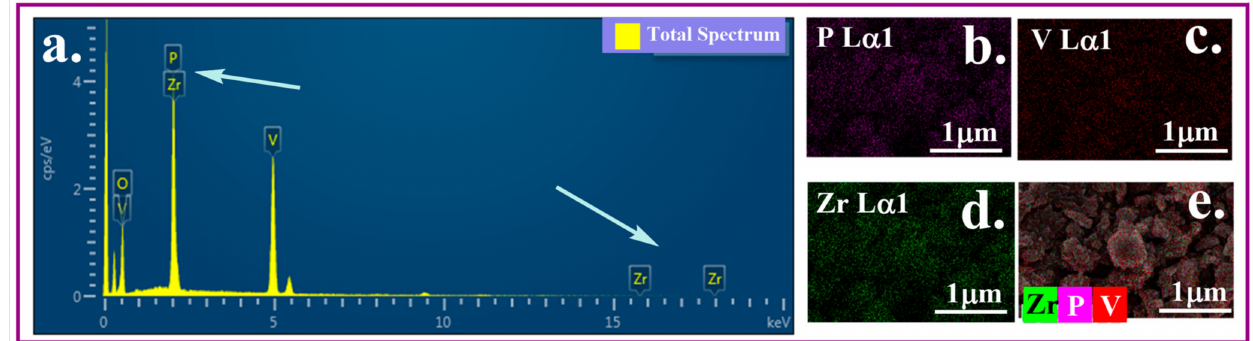
Figure 12. The total EDS spectrum of the monometallic Zr-DES catalyst ( a ). EDS maps show the distribution of phosphorus ( b ), vanadium ( c ), zirconium ( d ), and all elements ( e